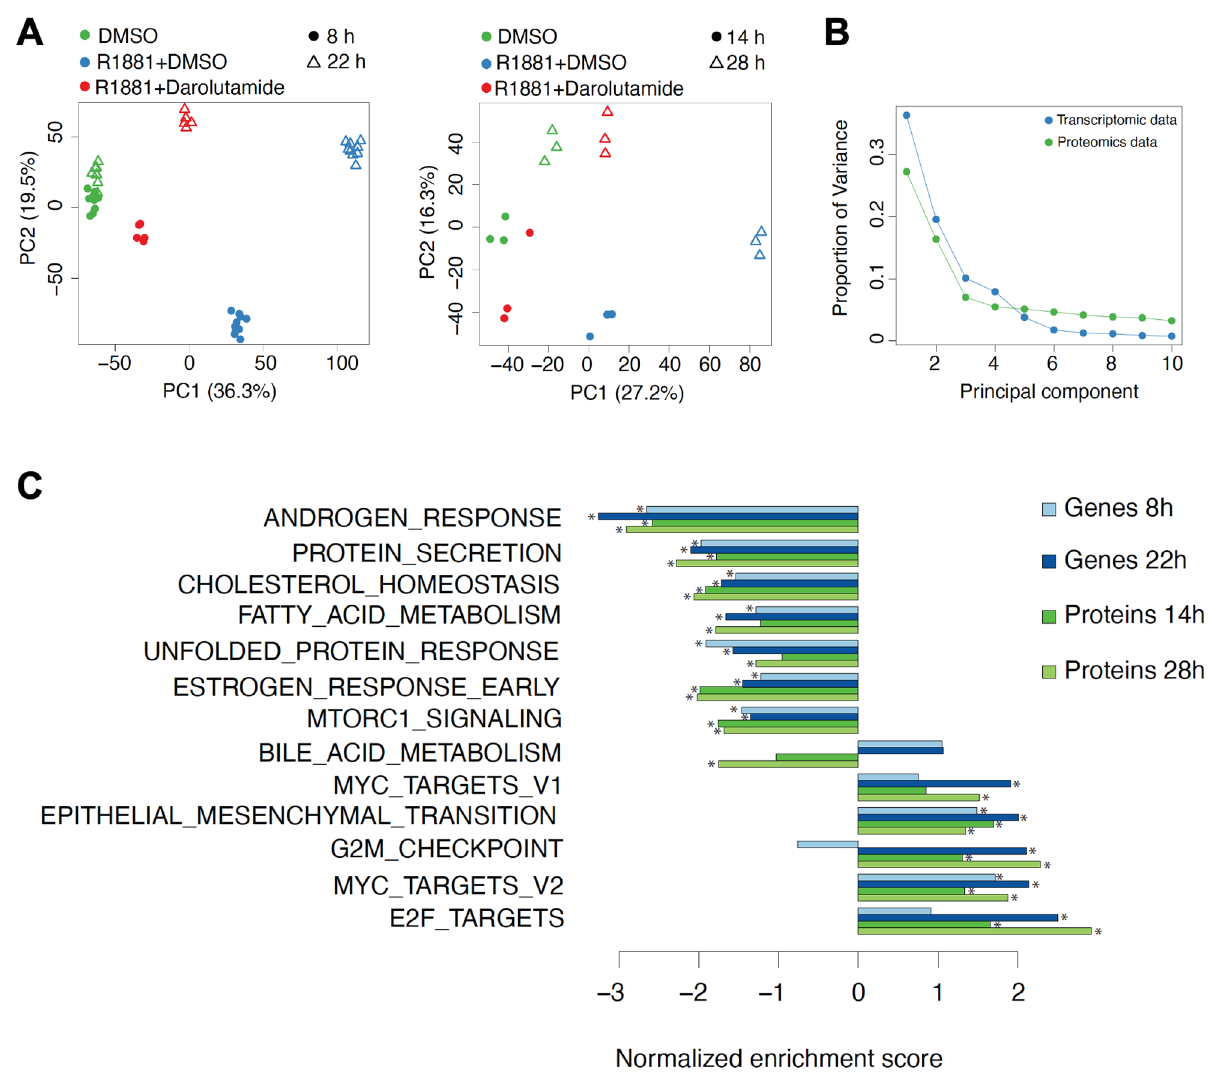
Figure 3. ( A ) Principal component analysis of transcriptomic and proteomic data generated from VCaP cells treated with DMSO, R1881 or R1881 and darolutamide for the indicated time. The percent of explained variance is indicated on the axes. ( B ) Proportion of variance explained by the first ten principal components in proteomic and transcriptomic data. ( C ) Top hallmark gene sets enriched among mRNAs and proteins that are down- or up-regulated at least twofold upon darolutamide and R1881 treatment, compared to R1881 treatment only. Stars (*) indicate FDR < 0.25.